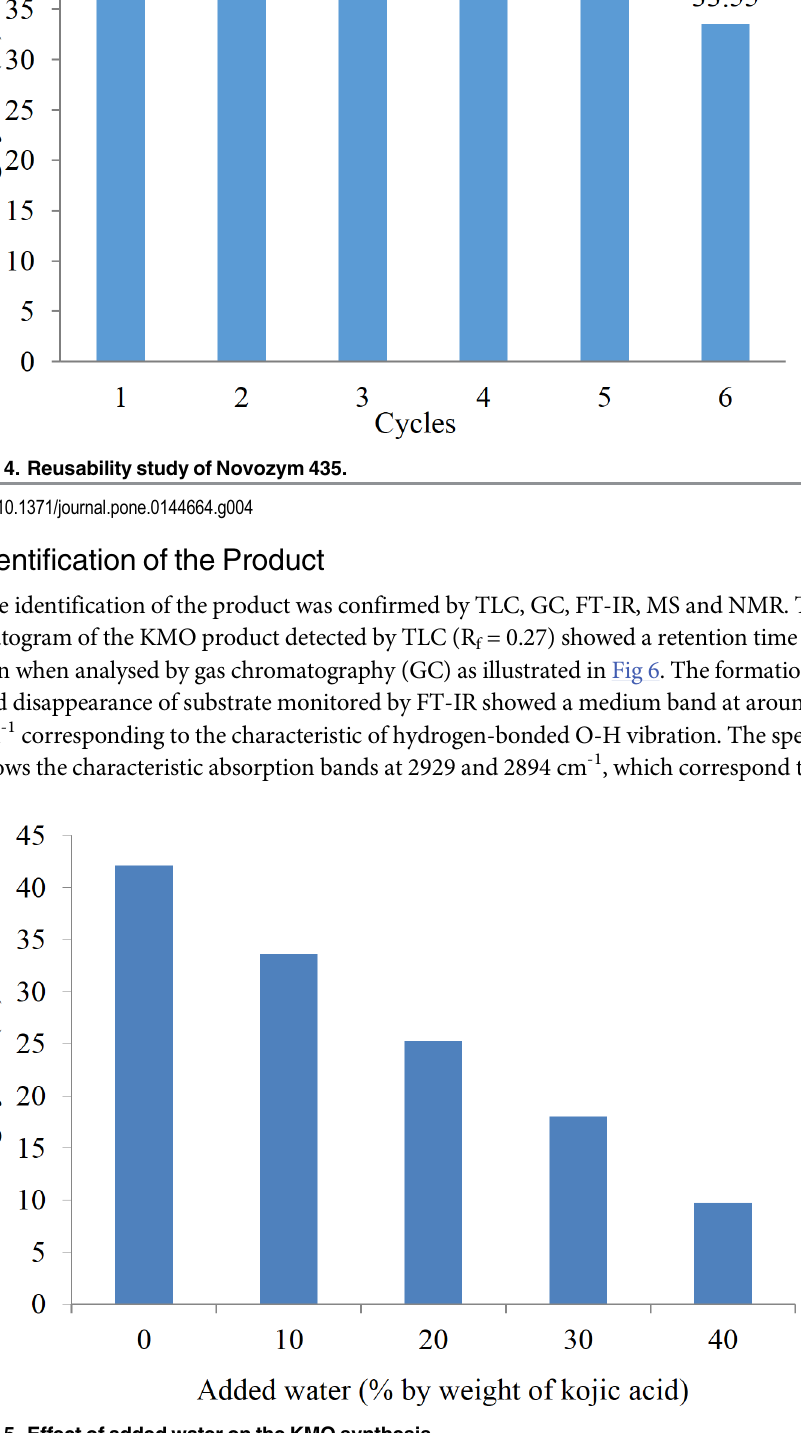
Fig 5. Effect of added water on the KMO